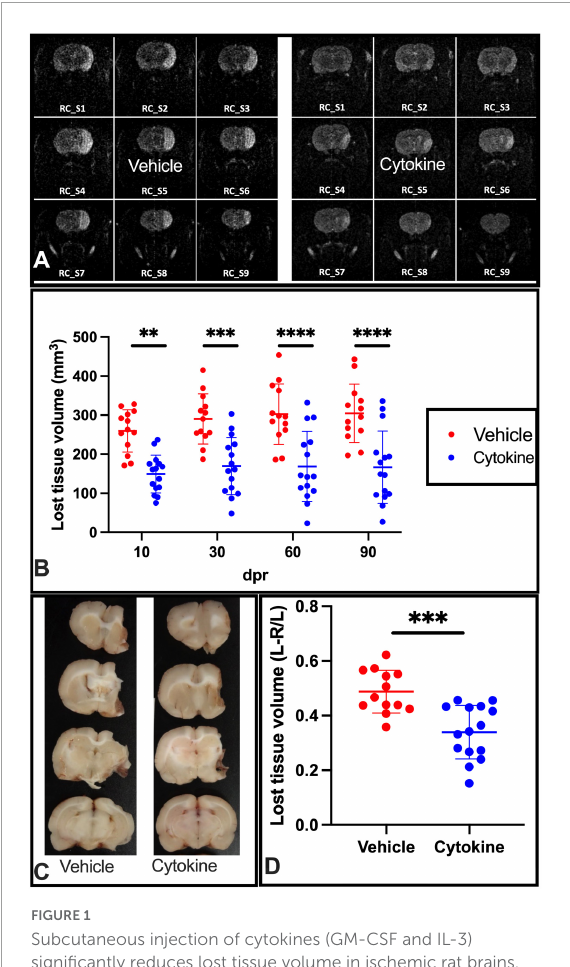
FIGURE1 Subcutaneous injection of cytokines (GM-CSF and IL-3) significantly reduces lost tissue volume in ischemic rat brains. (A) Representative MR images of vehicle-treated and cytokine-treated rats taken at 90 dpr. (B) Time course for MR images. Compared to the vehicle-treated group, the infarct volume (mm 3 ) is significantly smaller in the cytokine mixture-treated group. (C) Representative coronal brain section images in which the brain was dissected out, fixed in paraformaldehyde, and sliced at 90 dpr. (D) Bar graph shows significantly less brain volume loss in the cytokine-treated group than in the vehicle-treated group. Data ( n = 13–15) are shown as means ± SD and were statistically analyzed with two-way ANOVA for graph B and Student’s t- test for graph D. ∗∗ P < 0.01, ∗∗∗ P < 0.001, ∗∗∗∗ P < 0.0001 vs. vehicle. RC_S, rostro-caudal slice; GM-CSF, granulocyte macrophage colony-stimulating